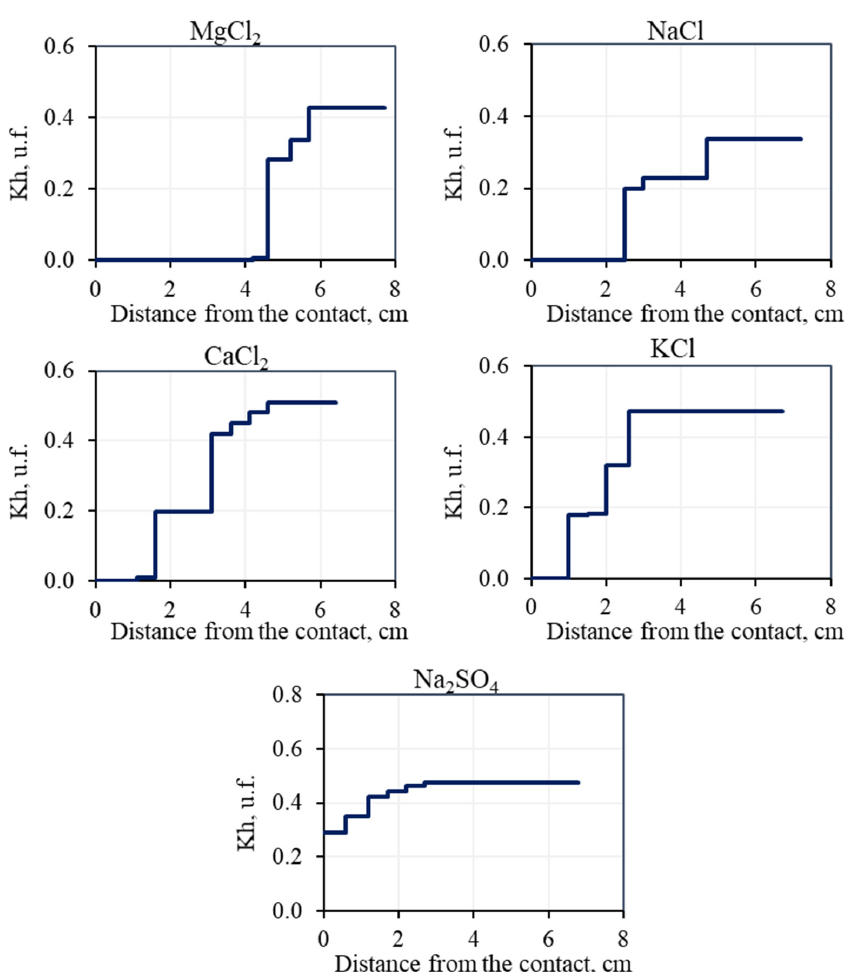
Figure 14. Variations of hydrate coefficient ( 𝐾 (cid:3035) ) along frozen hydrate-bearing sand samples ( 𝐾 (cid:3035)(cid:3036)(cid:3041) ~0.5, W = 12%) after 4 h of interaction with 0.1 N CaCl 2 , KCl and NaCl solutions at − 6.5 °C and 0.1MPa.